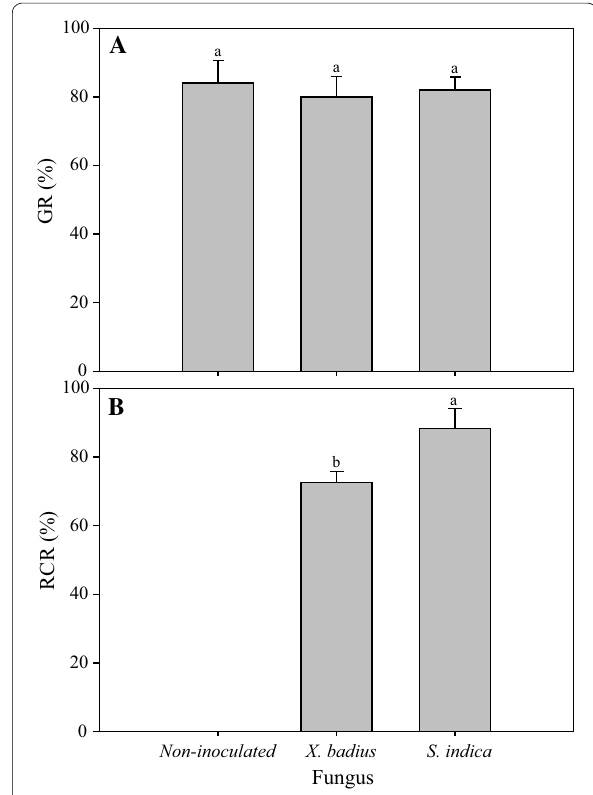
Fig. 1 Effect of X. badius and S. indica inoculation on GR ( A ) and RCR ( B ) of L. multiflorum seedlings. GR seed germination rate, RCR root colonization rate. Values are means of six replicates. Bars represent the standard deviation. Lowercases show statistically significant differences for the same parameter among L. multiflorum seedlings inoculated by X. badius and S. indic a at P